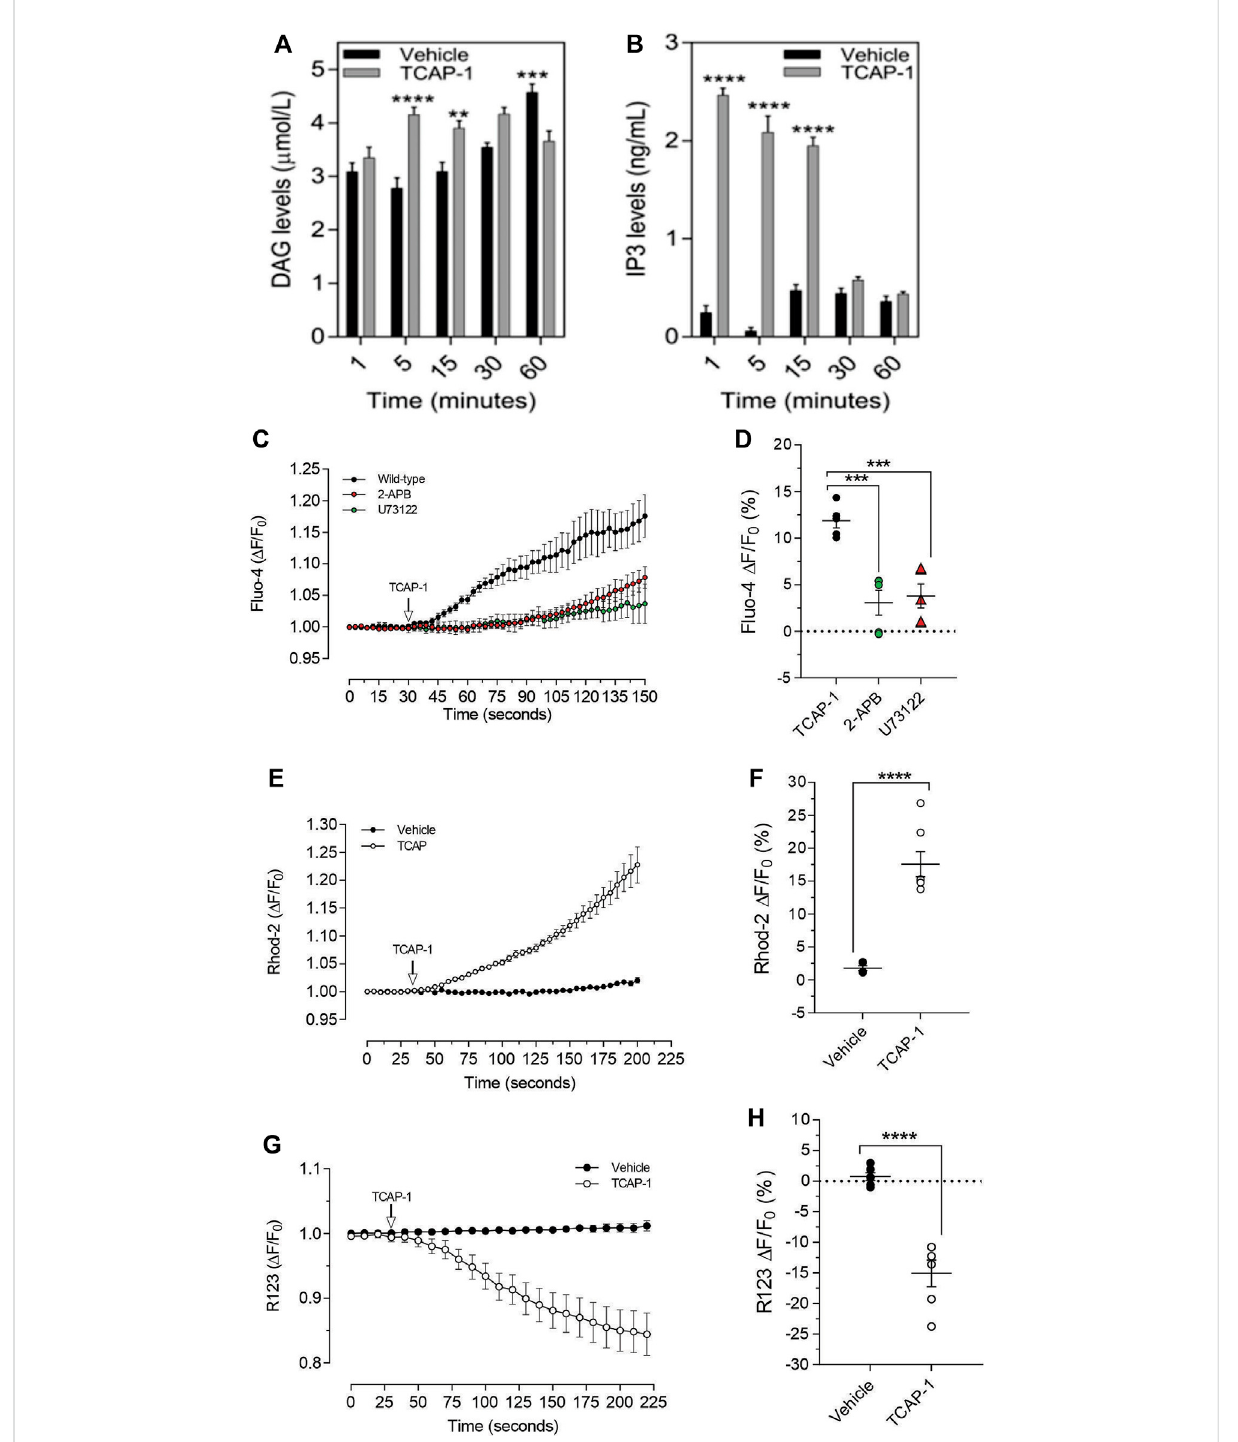
FIGURE 9 T CAP-1mediatedcalciumregulationinC2C12 cells. (A) .TCAP-1mediatedincreaseinintracellularDAGconcentrations(meanandSEMshown; n =6). (B). TCAP-1mediatedincreaseinintracellularIP3concentrations(meanandSEMshown; n =6). (C). IncreaseinintracellularTCAP-1mediated Ca 2+ concentrationsandinhibitionbytheIP3receptor(2-APB)andphospholipaseC(U73122)antagonists; (D) .Quanti fi cationofdatashowninC( n = 6). (E). Uptake in Ca 2+ -mediated Rhod-2 into mitochondrial membranes. (F) . Quanti fi cation of data shown in “ E ” based on the change at 200 s. (G) . Decrease in Rhod-123 immuno fl uorescence in mitochondrial membranes as a result of TCAP-1 administration. This decrease in Rhod-123 indicates a decrease in mitochondrial membrane depolarization. (H) . Quanti fi cation of the data indicated in G based on the changes at 225 s (* p < 0.05; ** p < 0.01; *** p < 0.001; **** p < 0.0001.) Note that in this Figure, that F/F0 has been set to “ 1 ” for